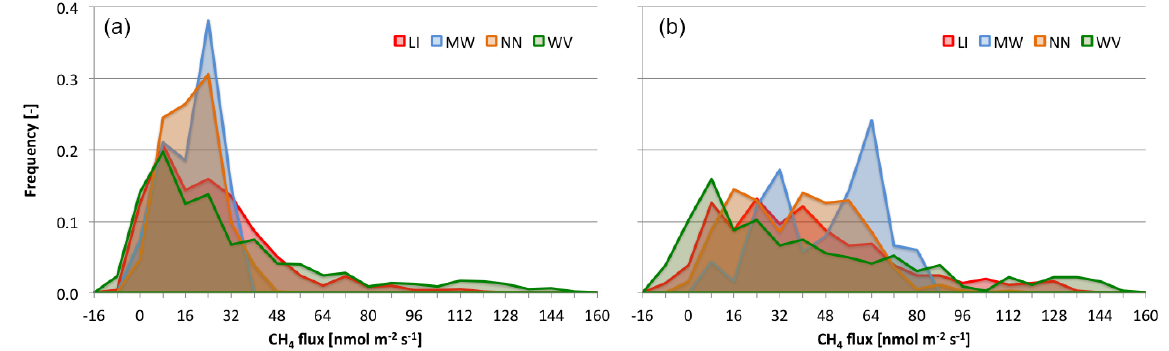
Figure 2. Frequency distribution of flux rates ( a , tower 1; b , tower 2) produced by the three gap-filling approaches (red: linear interpolation – LI; blue: moving window – MW; orange: neural network – NN) compared against the reference flux values derived from the wavelet raw data processing method (WV; green).